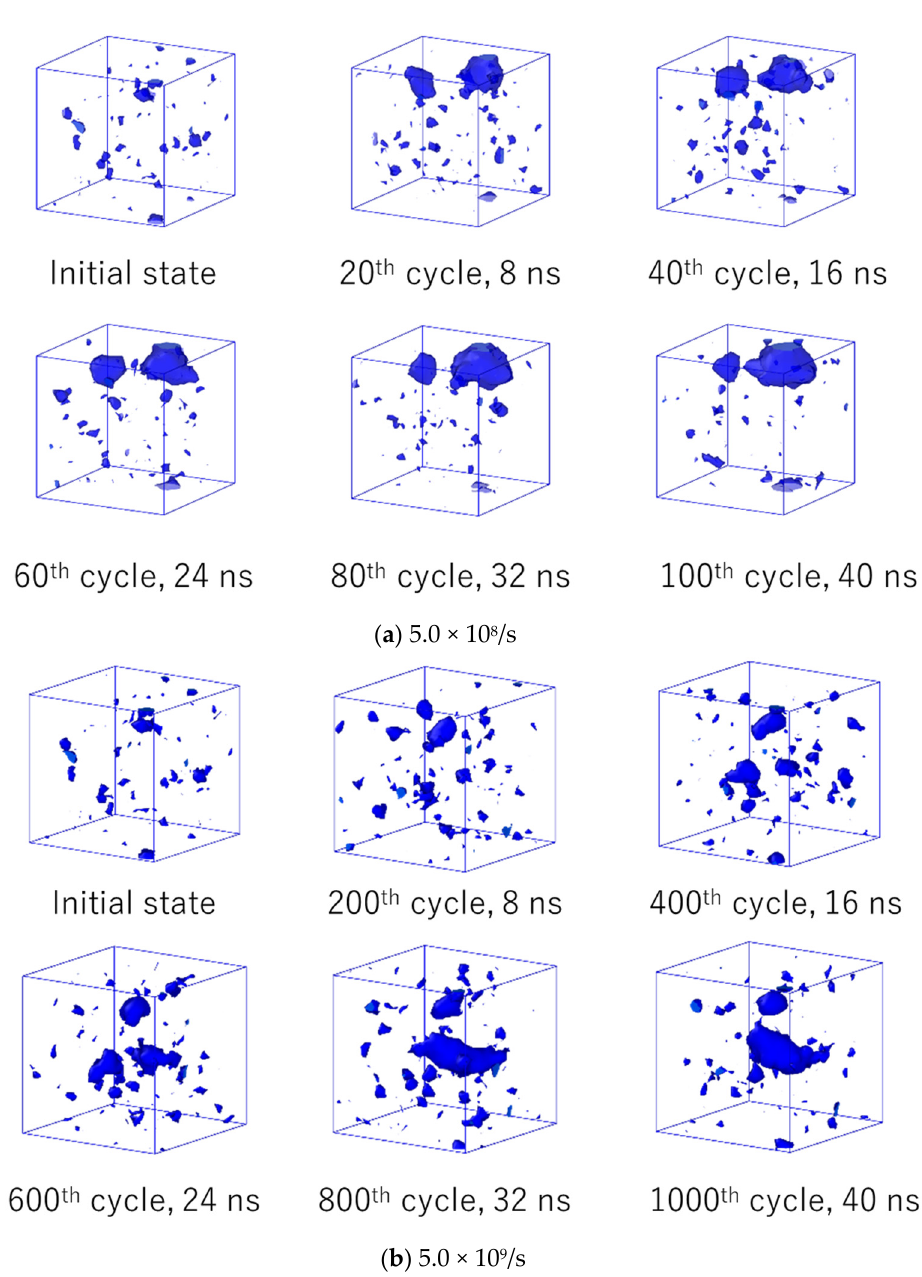
Figure 9. Snapshots of the time evolution of the spatial distribution of voids.